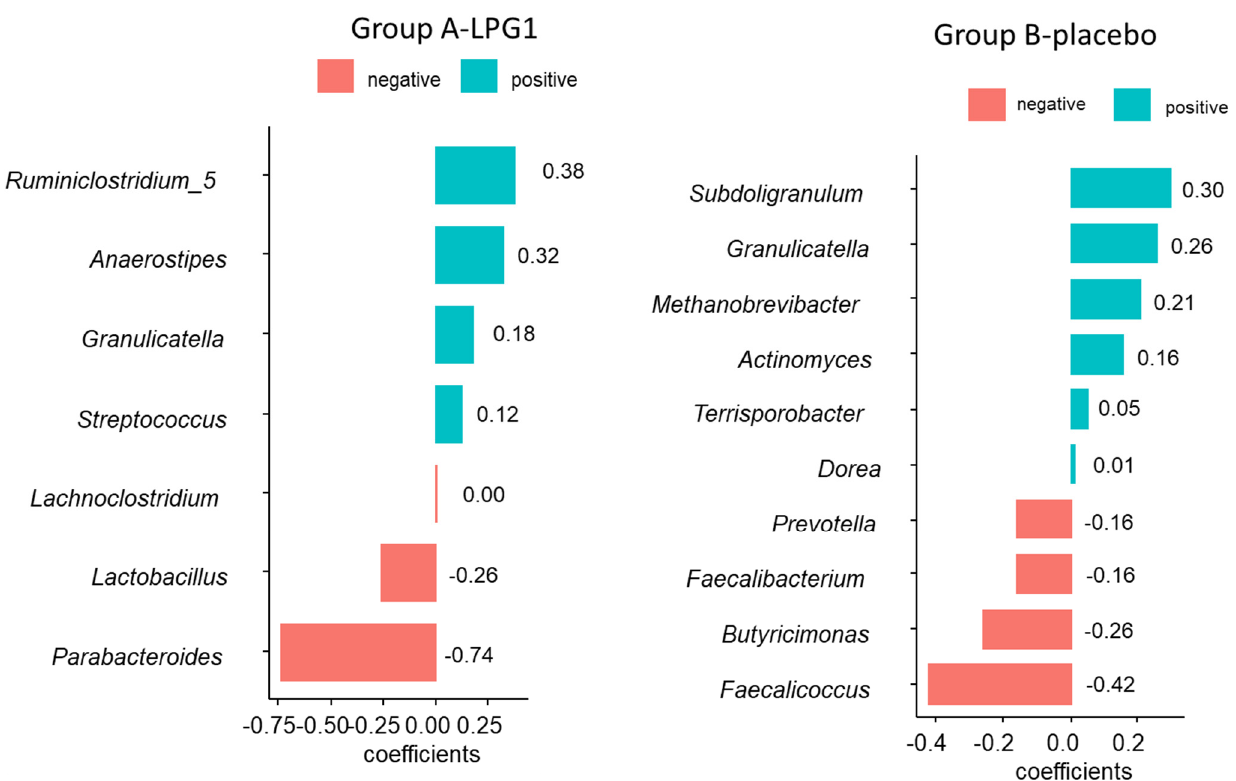
Figure 5. ASVs selected by coda4microbiome R package (logistic regression) for segregating samples from the initial (I) and final (F) phases of A—LPG1 and B—placebo groups included in the randomised, placebo-controlled, single-blind trial to study the effect of oral intake of L. pentosus LPG1 on the human gut microbiota.. The balance consisted of the positive coefficients in the numerator and the negative in the denominator. Notice that the Lactobacillus genus was selected to differentiate between trial phases in A—LPG1. The selection and increase in Parabacteroides during the experiment were also relevant to this aim. However, Lactobacillus did not play any role in segregating samples from the two B—placebo phases.